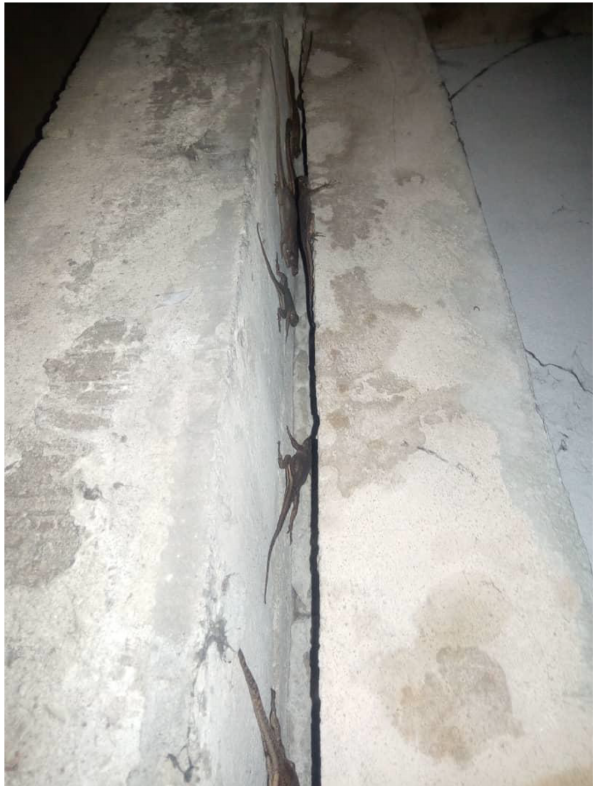
Figure 2. Example of overnight clustering on walls in Agama agama from the study